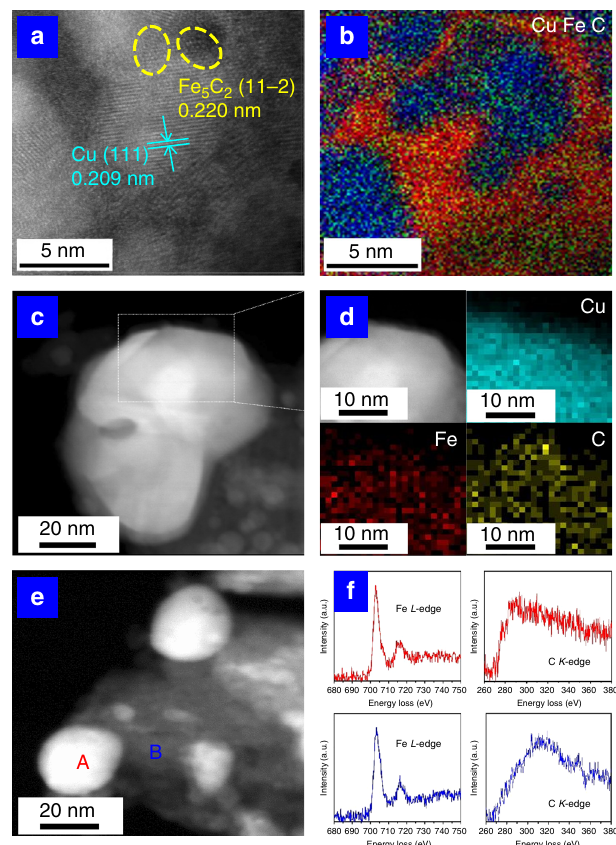
Fig. 3 Structural studies on Cu 4 Fe 1 sample. a HRTEM image; b EELS mapping of Cu (blue), C (red), and Fe (green) of ( a ). quasi-in-situ STEM: c HAADF-STEM image; d EDS mapping of the selected region (white box in c ) showing elemental distribution of Cu, C, and Fe; e HAADF-STEM image and f EELS curves of Fe L-edge and C K-edge selected from ( e ) (Spot A: red, Spot B: